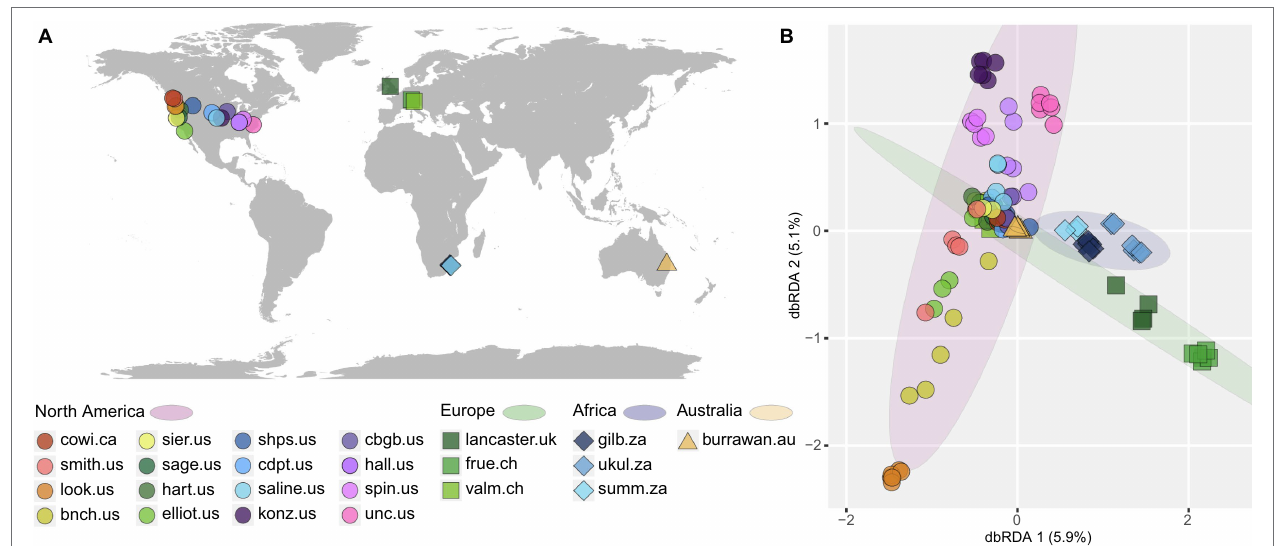
FIGURE 1 | (A) Global distribution of all studied temperate grassland soils, (B) distance-based redundancy analysis (dbRDA) displaying the effect of study sites on the Bray–Curtis dissimilarity of diazotrophic communities. Each color represents one collection site. Only samples from non-addition plots were used here. Shapes denote the respective continent and ellipses encompass sites from the same continent. More information on sampling sites and their geographic locations can be found in Supplementary Table S1